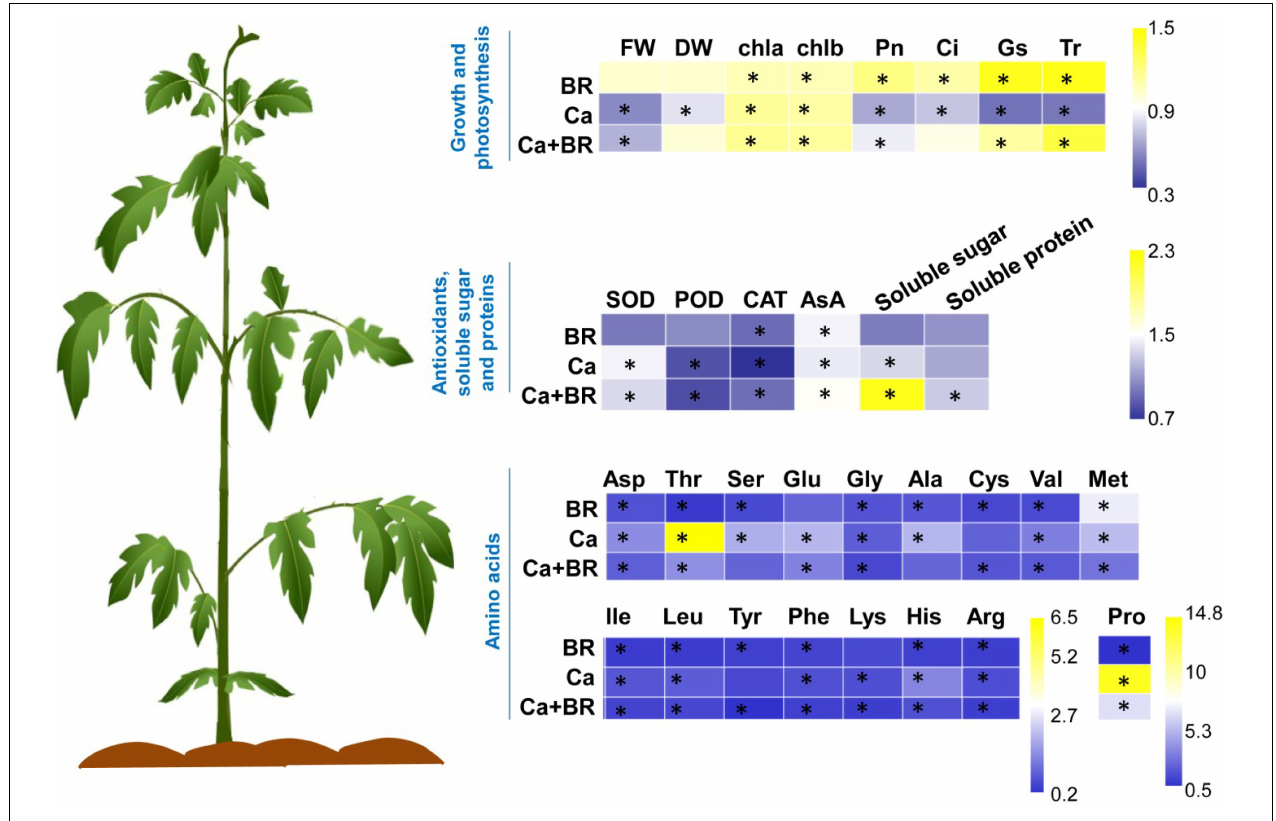
FIGURE 8 | Brassinolide alleviated Ca(NO 3 ) 2 -induced growth inhibition by modulating photosynthesis, antioxidants, osmoregulatory substances, and amino acid contents in tomato seedlings. The heatmap represents the fold change of each value compared with the corresponding untreated control. Asterisks indicate that values were significantly different compared with the untreated control plants at P <